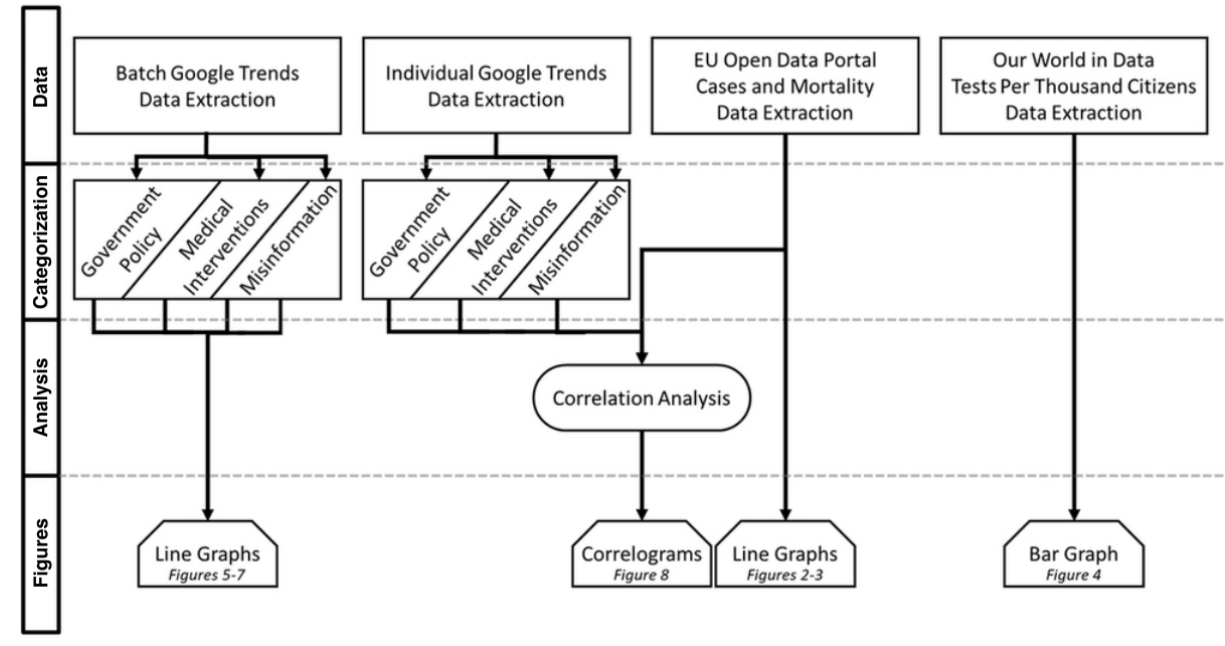
Figure 1. Data extraction and